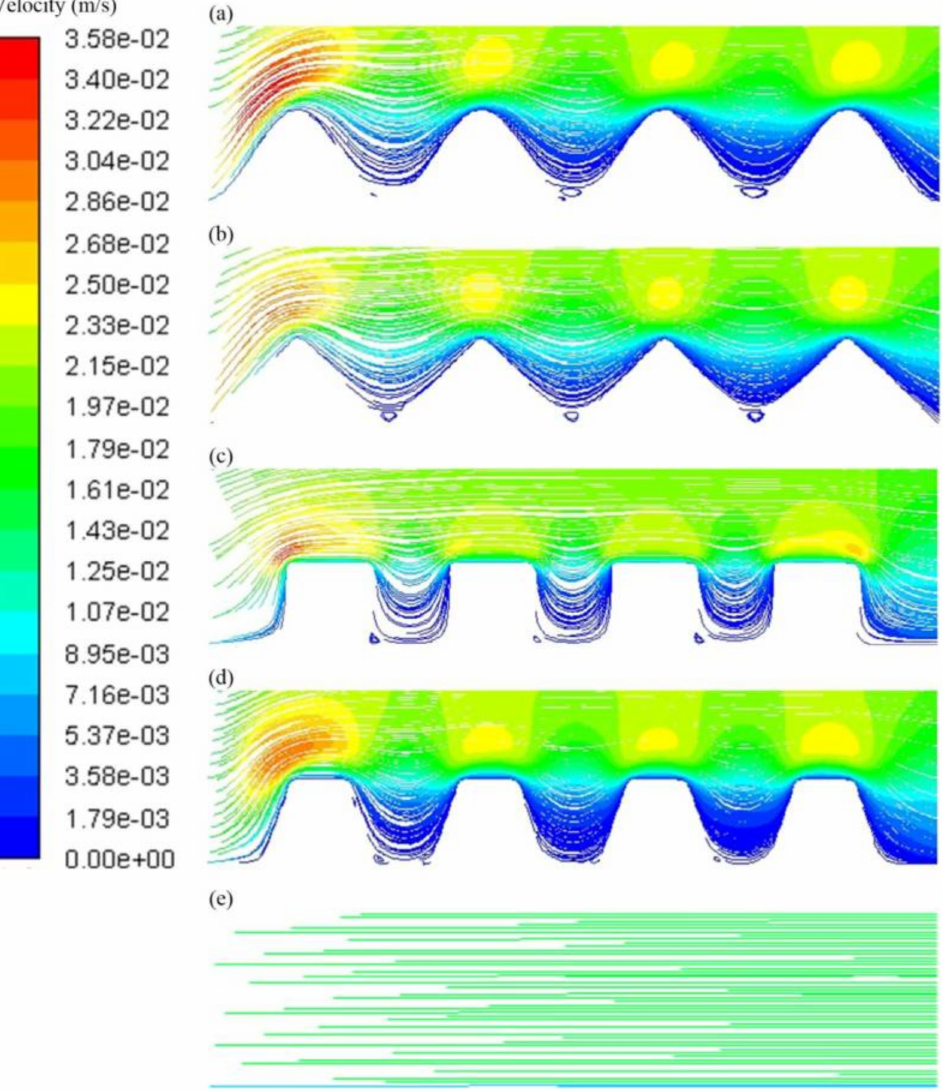
Figure 3. Comparison of the velocity streamline profiles near the membrane surface simulated by computational fluid dynamics (CFD) simulation of ( a ) wave, ( b ) triangle, ( c ) rectangle and ( d ) trapezoid patterned membranes vs. ( e ) a flat membrane at Reynolds number (Re ) = 109. Red and blue colors represent higher and lower velocities, respectively. In the cases where a patterned membrane was used ( a – d ), the vortices formed in the bottom of the valley region may alleviate microalgal cell deposition. In contrast, the flat membrane exhibited a constant low-flow behavior which may not be high enough to reduce fouling. Reprinted from Zhao et al. [69], Copyright 2021, with permission from